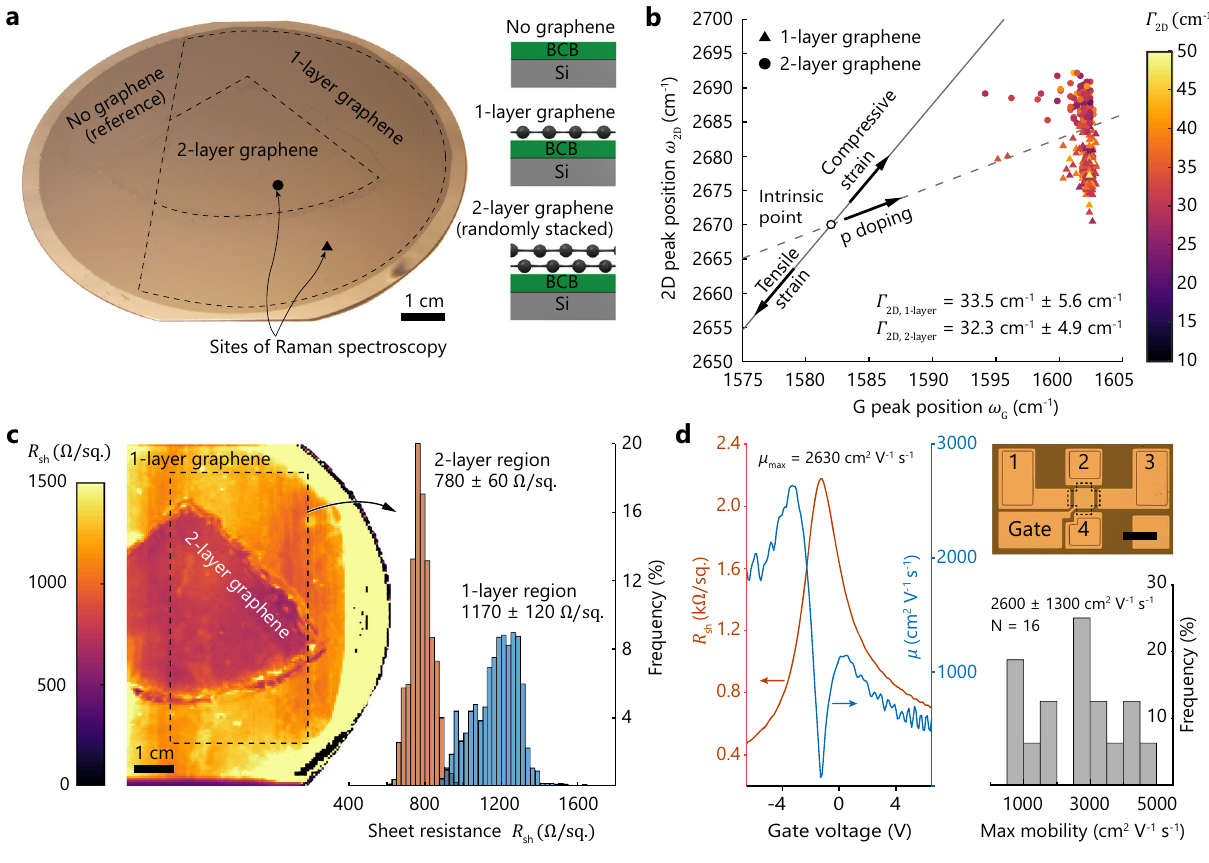
Fig. 3 Characterization of double-layer (2-layer) graphene formed by two consecutive transfers of monolayer (1-layer) CVD graphene and wafer-level integration of top-gated fi eld-effect graphene devices. a Photograph of a high resistive silicon wafer with 100-mm diameter after graphene transfer. Dashed lines indicate regions of single-layer, double-layer, and no graphene (only bisbenzocyclobutene (BCB)). b Correlation map of Raman G and 2D peak positions ( ω G and ω 2D , respectively), extracted from measurements in regions of 1-layer graphene (triangles) and 2-layer graphene (circles). The colormap represents the full-width at half-maximum of the 2D peak ( Γ 2D ) of single-layer graphene ( Γ 2D,1-layer ) and double-layer graphene ( Γ 2D,2-layer ). c Spatially resolved map of the graphene sheet resistance ( R sh ) from noncontact terahertz near- fi eld spectroscopy (left), clearly showing decreased R sh in the 2-layer graphene region. The histogram (right) represents the data inside the dashed rectangle (blue: 1-layer region; red: 2-layer region). d Top-gate voltage dependency of the graphene sheet resistance and the fi eld-effect mobility in an integrated graphene device at room temperature (left) and histogram of the maximum fi led-effect mobility ( μ max ) of 16 devices at room temperature (bottom right). Optical microscope picture of a fabricated fi eld-effect graphene device (top right). The dashed line marks the graphene area. Electrodes 1 to 4 are used for electrical characterization by a 4-point probe van der Pauw method, while the gate voltage tuned the doping of the graphene. Scale bar: 100 µ